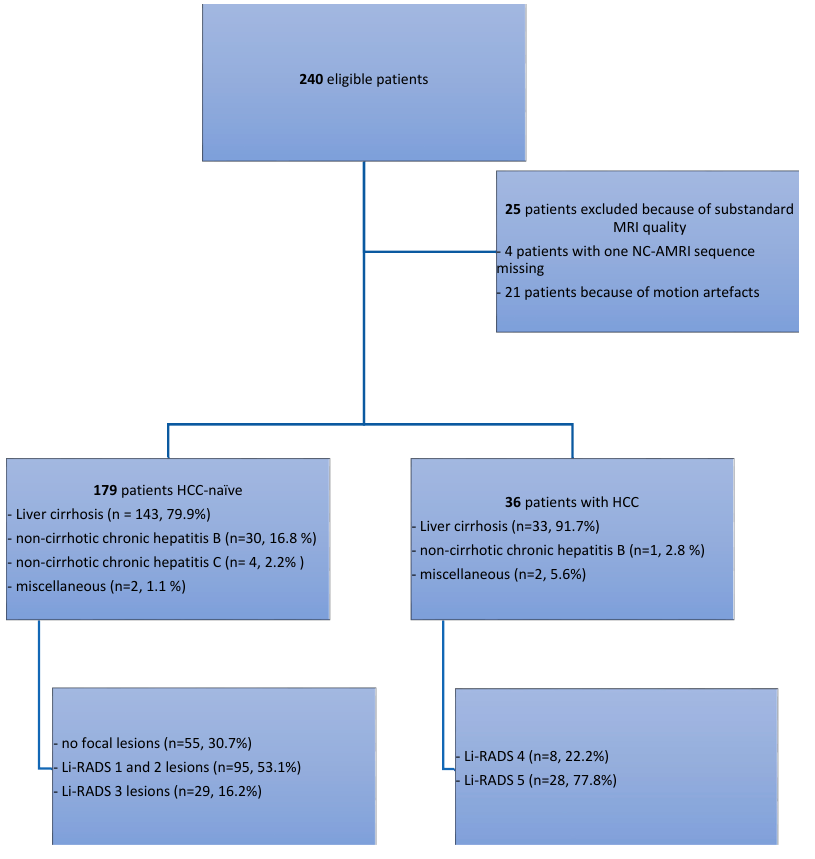
Scheme 1. Summary of patient sampling and characteristics of the study population. HCC: patients with hepatocellular carcinoma; HCC-naïve: patients without HCC.